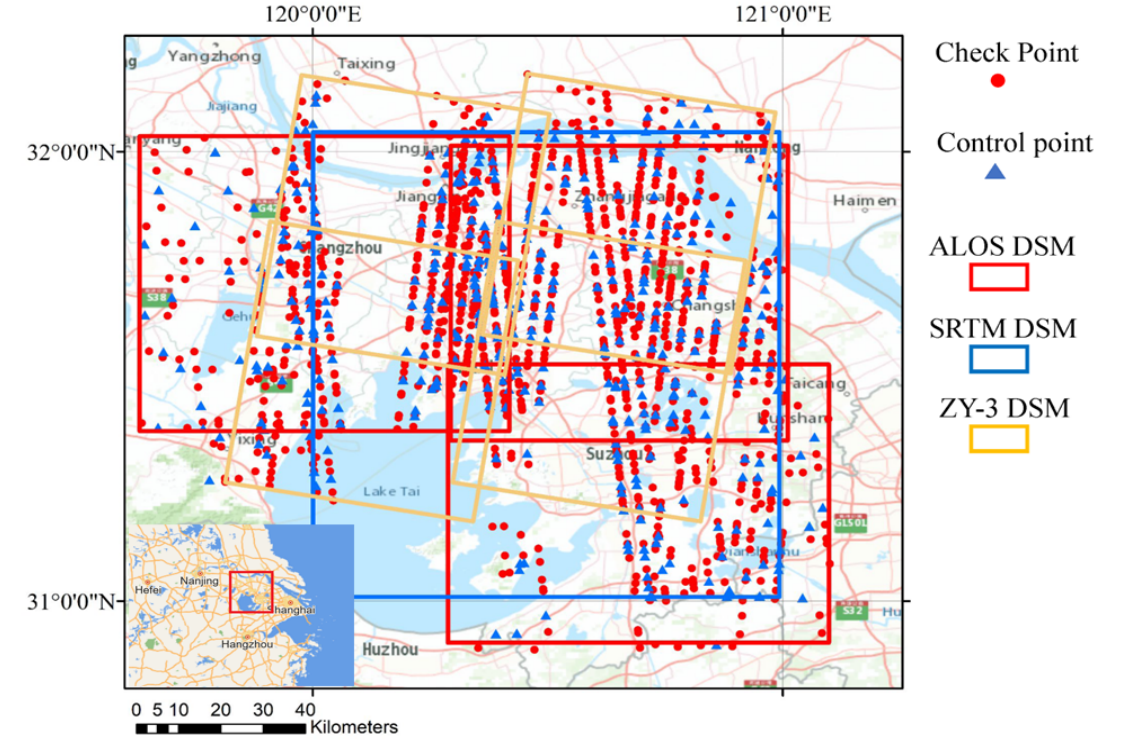
Figure 2. The distribution of the ZY-3, ALOS and SRTM DSMs (with the location of the elevation control and check points).